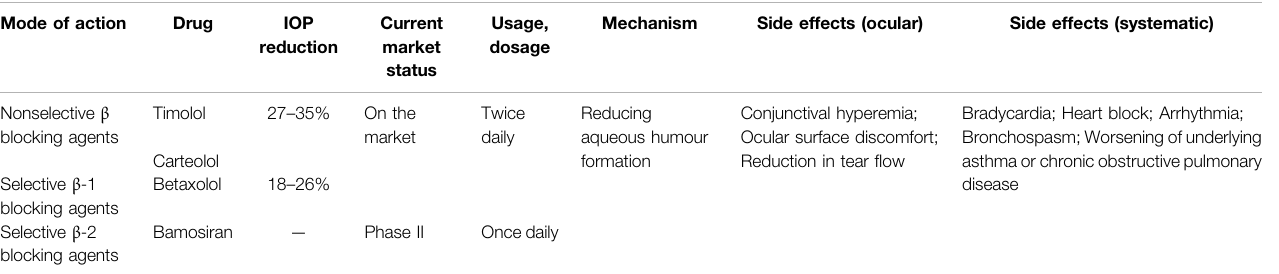
TABLE 3 | The class and list of β blocking agents.